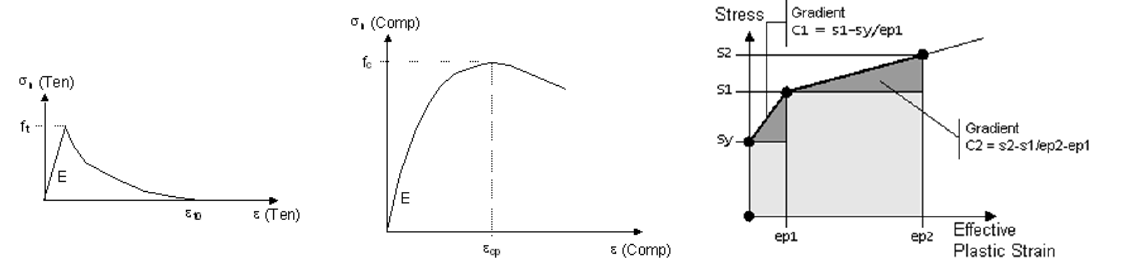
Figure 15: Constitutive law Cracking Concrete with Crushing Model Figure 16: Constitutive law for bar. Stress Potential